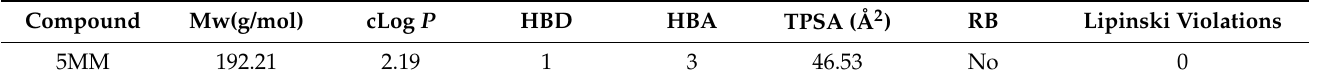
Table 4. Physicochemical parameters and Lipinski